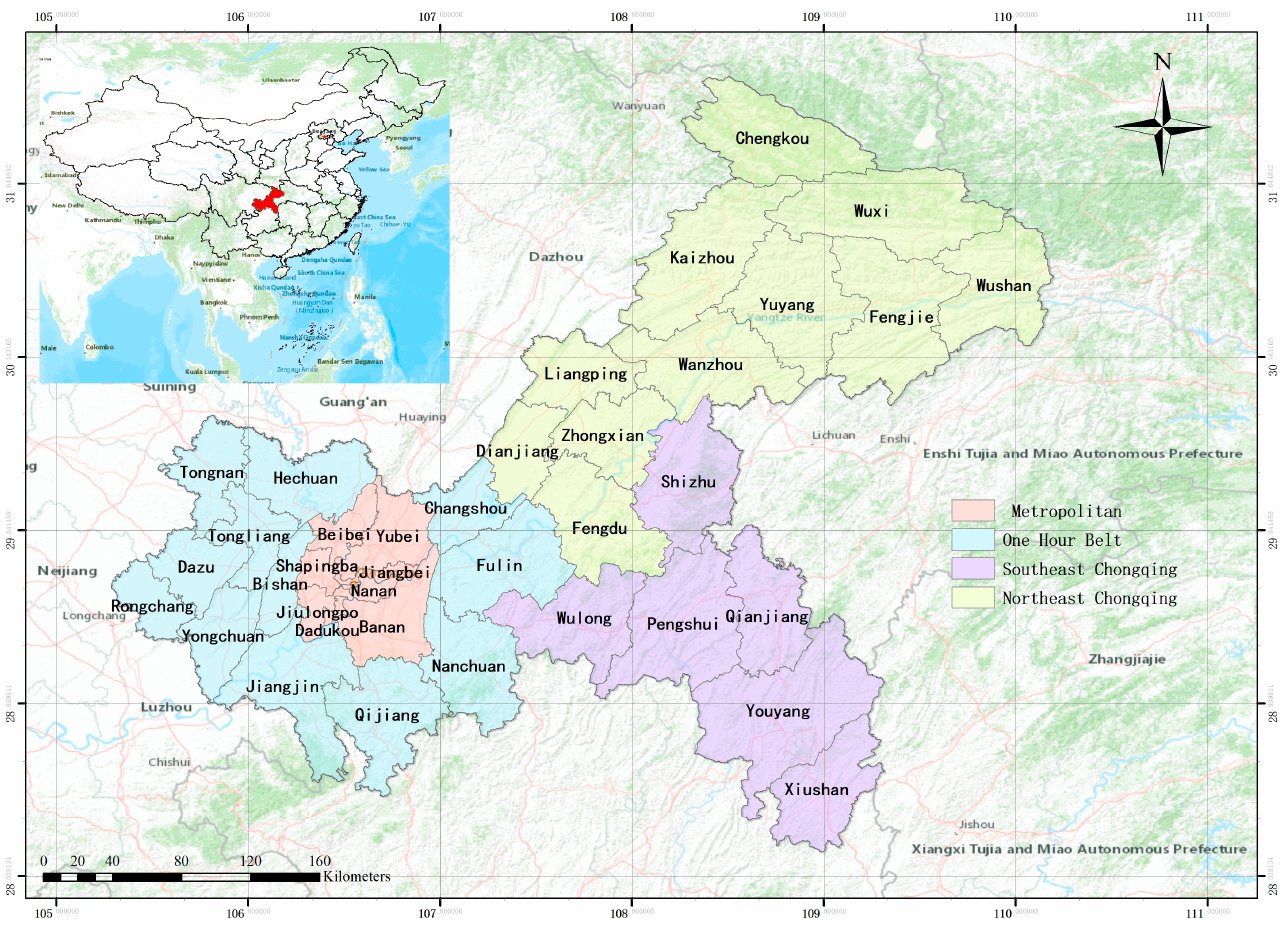
Figure 1. Location and administrative divisions of Chongqing in China.